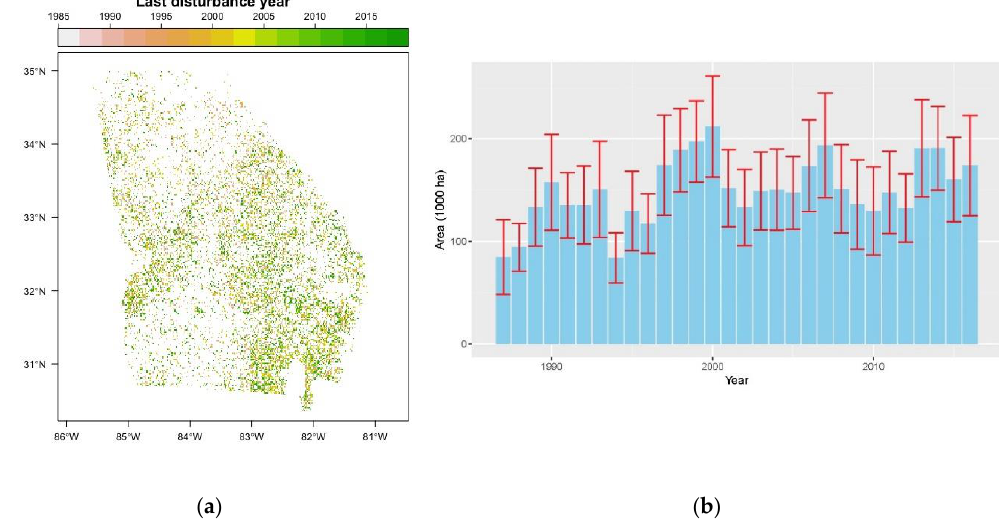
Figure 3. ( a ) The last disturbance year map. ( b ) Estimated area distribution of the last disturbance